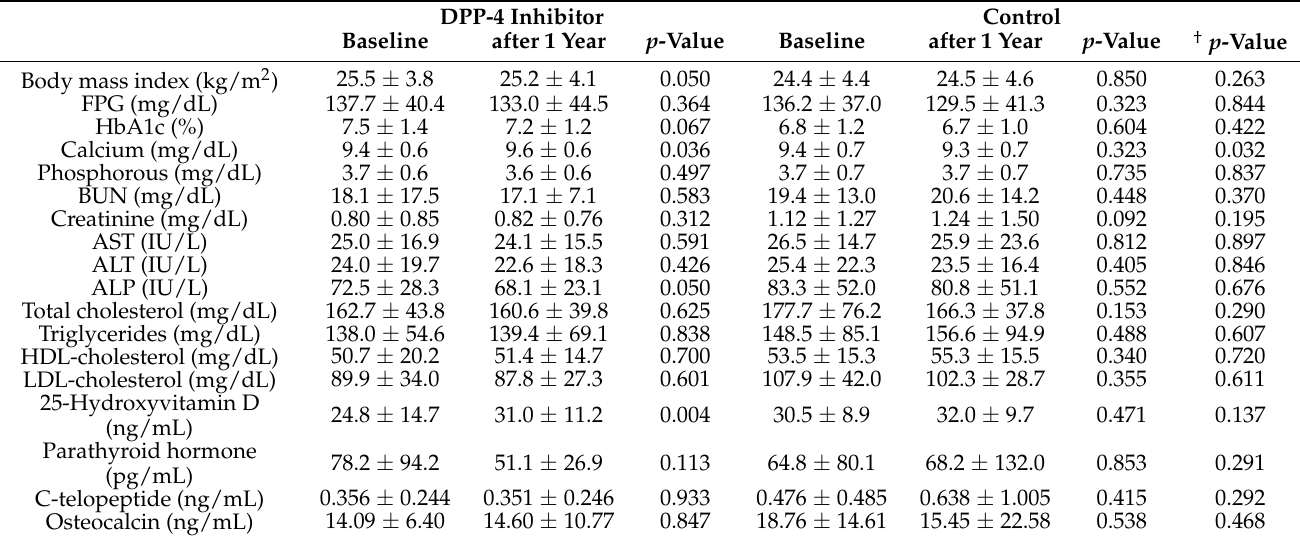
Table 3. Changes in the anthropometric variables and biomarkers.